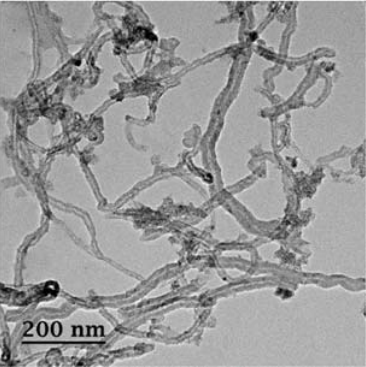
Figure 3. TEM image of an MWCNT/Fe 3 O 4 nanoparticle.